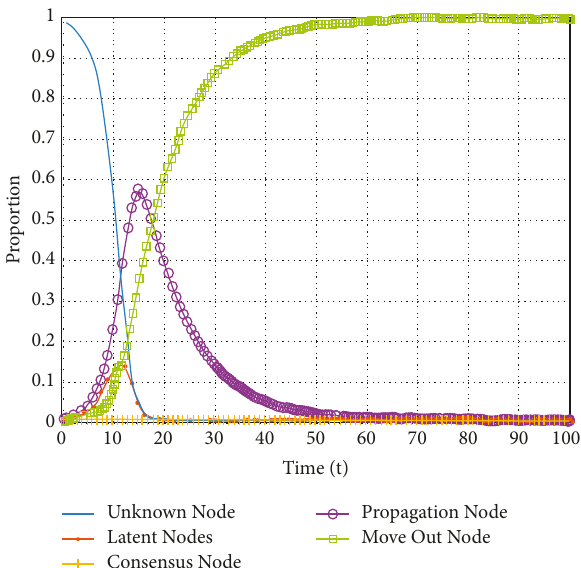
Figure 5: Effect of consensus nodes on information propagation.